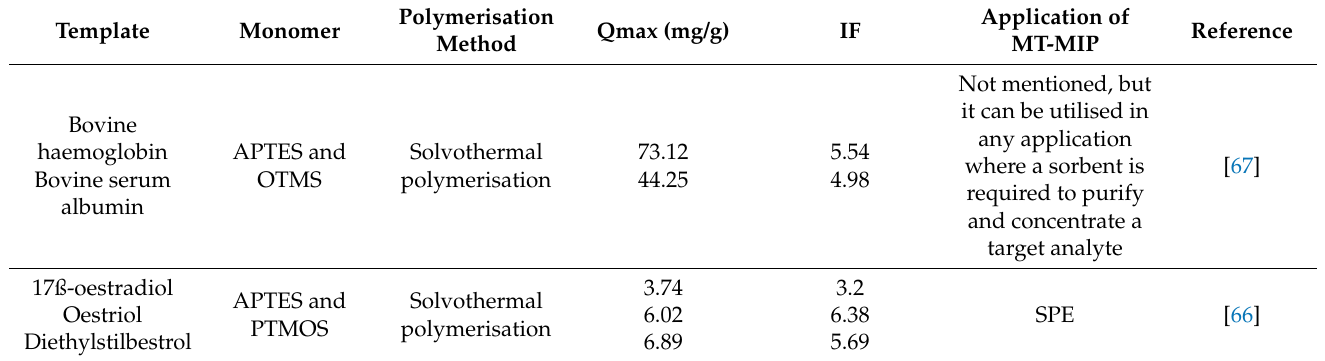
Table 6. Proteins used as templates in the synthesis of multi-template molecularly imprinted